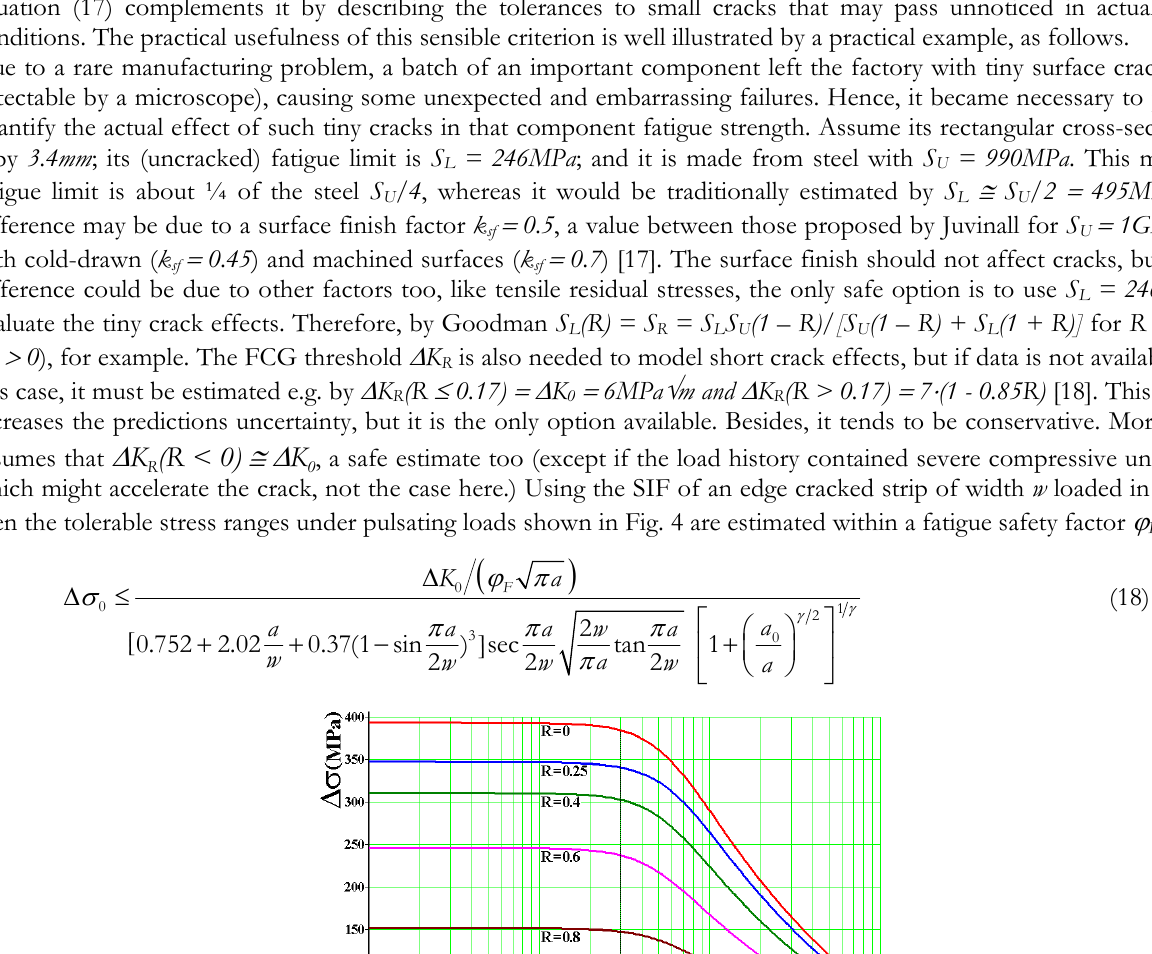
 6MPa  m , a  59  m ,   6 , and   1.6 0 0 F